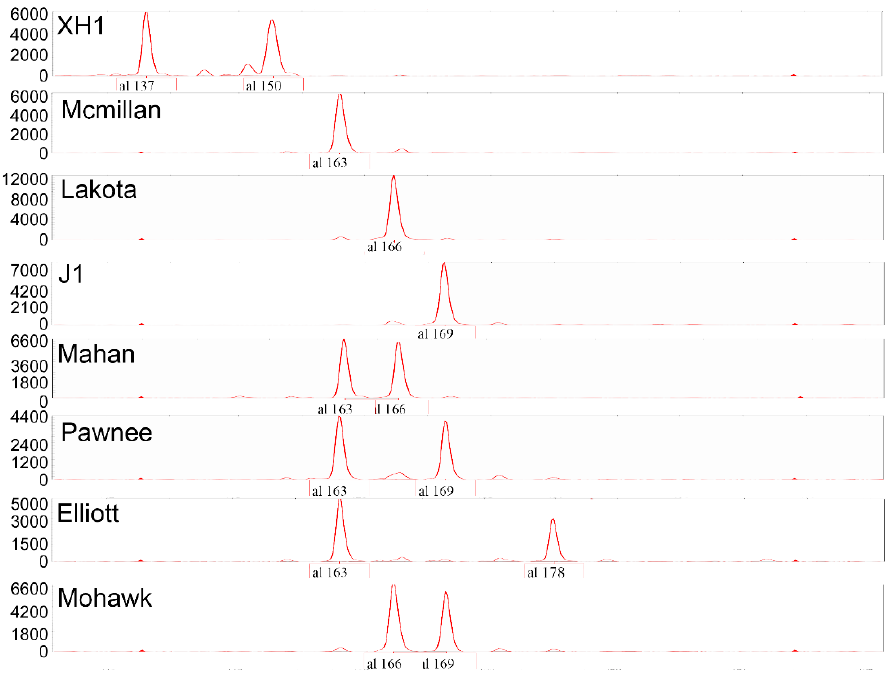
Figure 3. The capillary electrophoresis patterns of primer Ciz003 in eight pecan germplasms. Table 4. The cross-transferability of 30 SSR loci in three species.